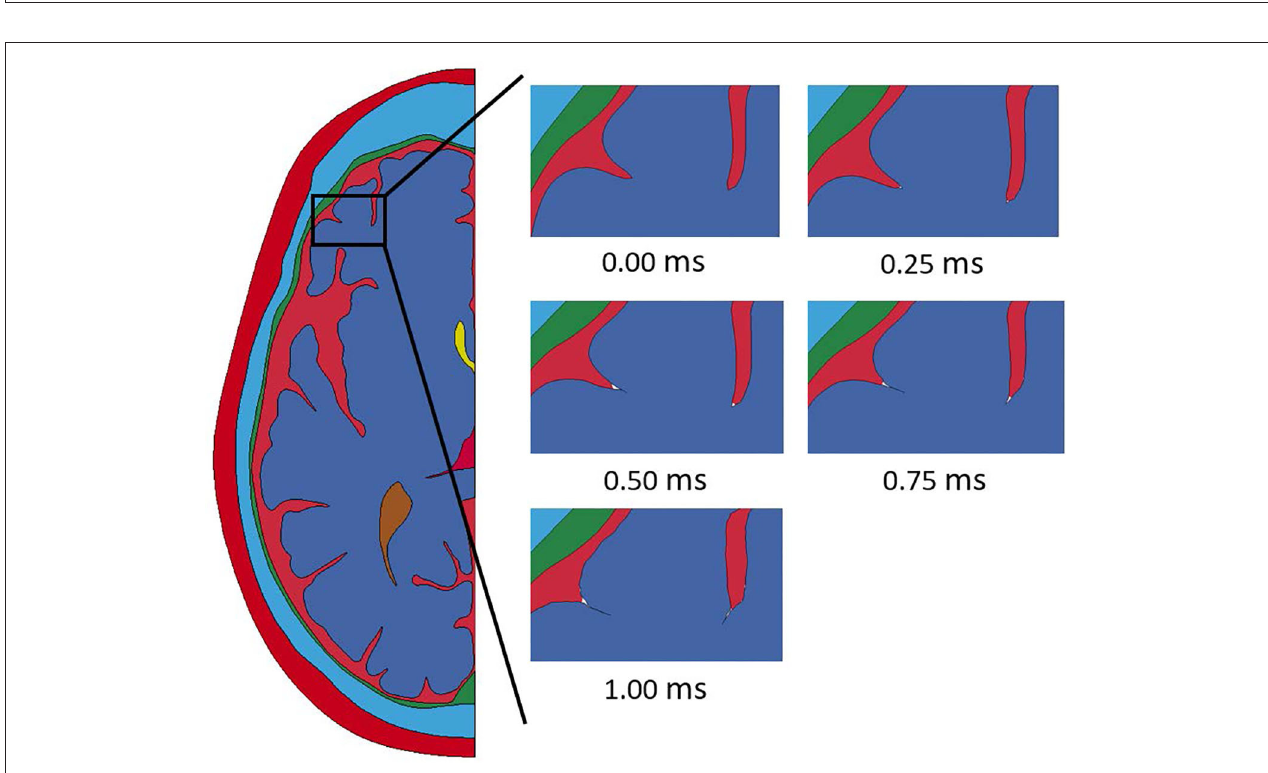
FIGURE 4 | Closure of sulci throughout the duration of the impact event modeled with a homogeneous brain homogeneous brain.